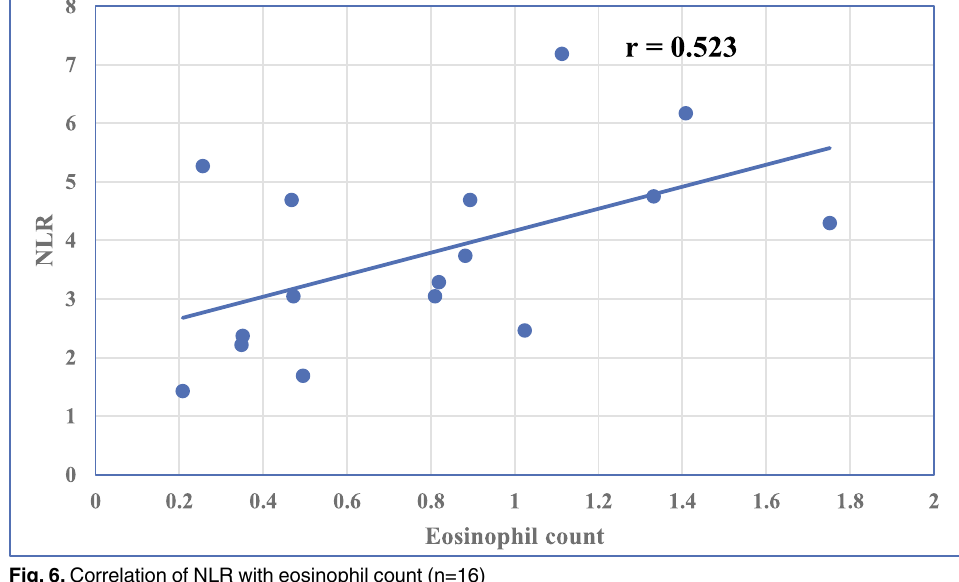
Fig. 6. Correlation of NLR with eosinophil count (n=16)